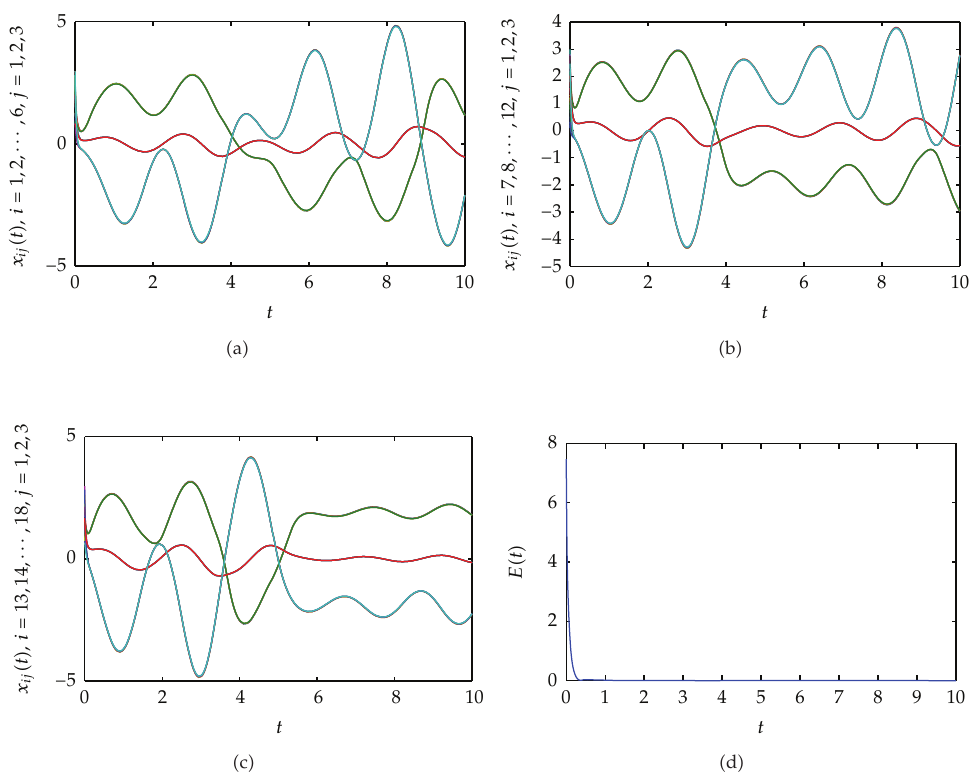
Figure 3: Cluster synchronization of a nonlinearly coupled Chua’s circuit network. (cid:6) a, b, c (cid:7) The trajectory of the nodes. (cid:6) d (cid:7) The error dynamics of the above Chua’s circuit